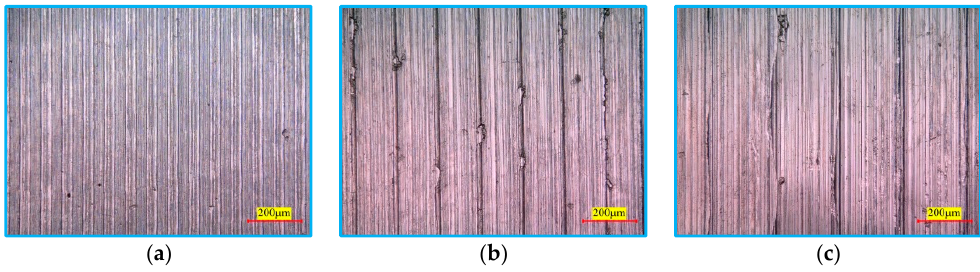
Figure 7. Surface topography of finish-machined SLMed 316L stainless steel ( V c = 150 m/min). ( a ) f = 0.08 mm/rev; ( b ) f = 0.16 mm/rev; ( c ) f = 0.24 mm/rev.